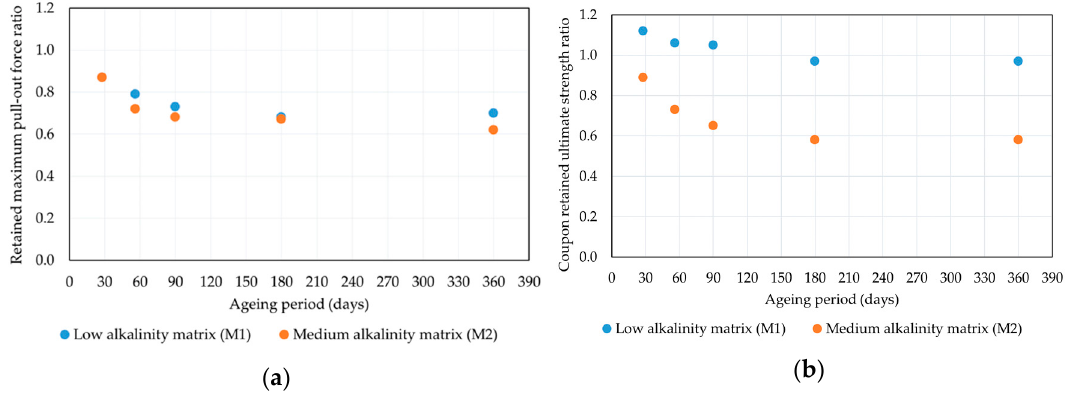
Figure 10. Effect of the matrix alkalinity on the ( a ) maximum pull-out force and ( b ) ultimate tensile strength of the FRCM coupons tested by Butler et al. [27,47].